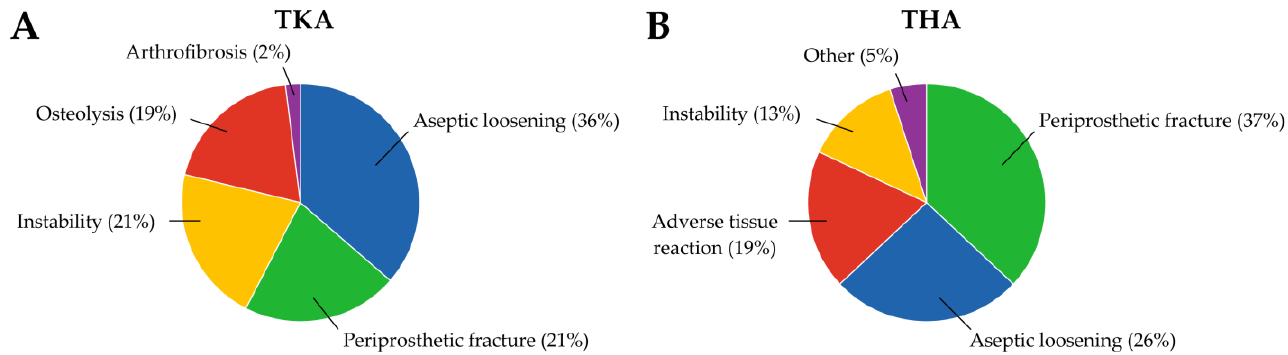
Figure 2. Common causes of non-infectious arthroplasty involving ( A ) total knee arthroplasty (TKA) and ( B ) total hip arthroplasty (THA). TKA data are from Abdel, M.P. et al. Bone Joint J 2017 , 99-B, 647–652 [64]. THA data from Ledford, C.K. et al. J Am Acad Orthop Surg 2019 , 27 [12]. Graph created in GraphPad Prism v9.4.0 (San Diego, CA, USA).